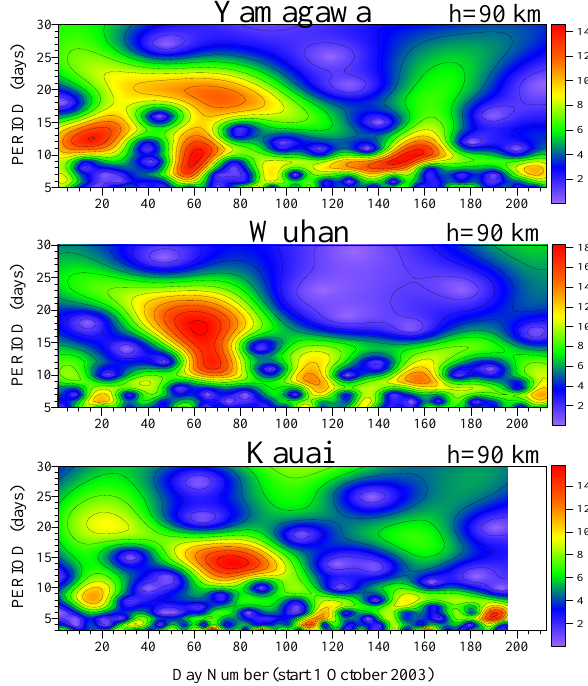
Figure 12 Fig. 12. Wavelet spectra calculated in the period range from 3 to 30 days for the zonal wind at 90km height measured at tropical stations Yamagawa, Wuhan and